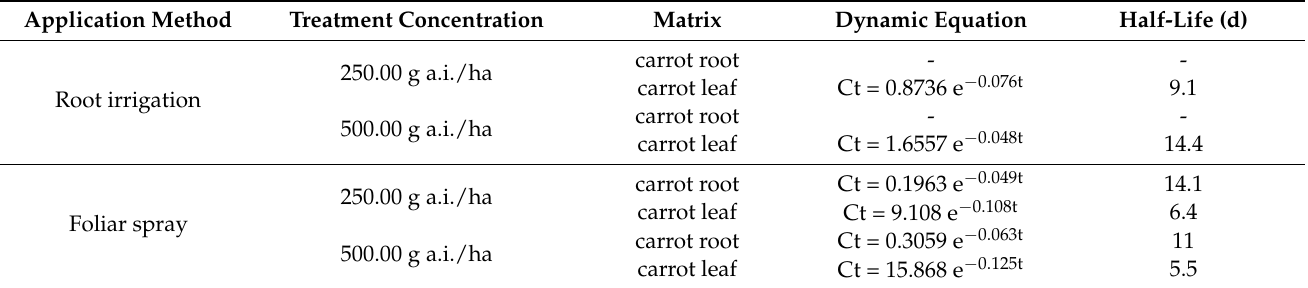
Table 4. Dynamic models of fluopyram in carrot samples from the two application methods.